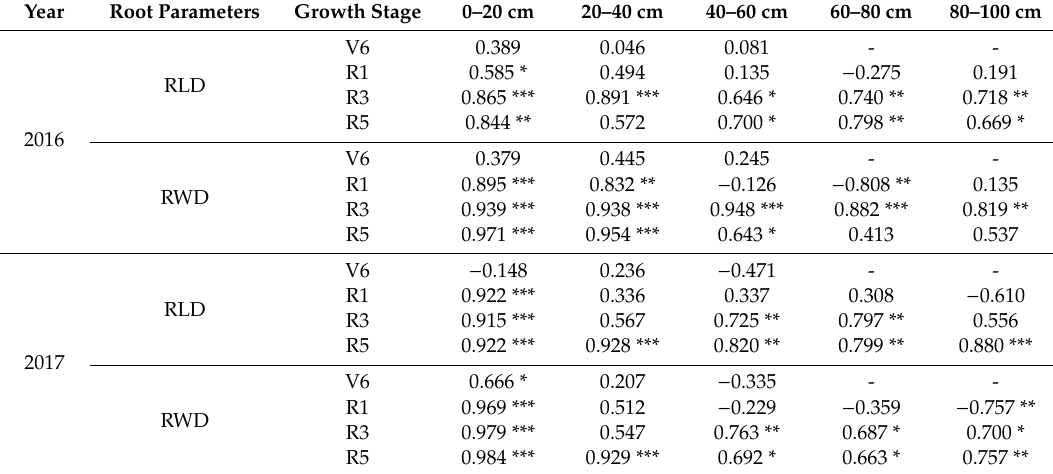
Table 3. Correlation coe ffi cients between root parameters (root length density (RLD) and root weight density (RWD)) over various soil depths with di ff erent growth stages under three N application treatments and maize grain